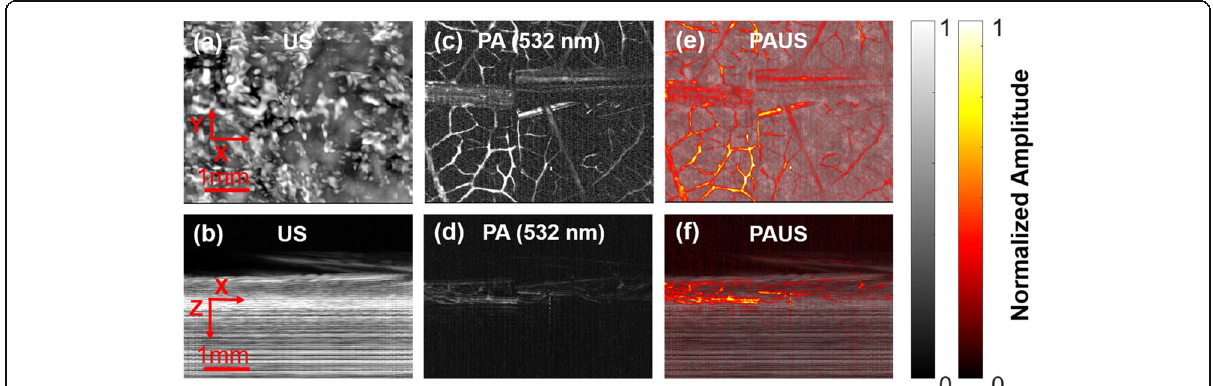
Fig. 2 Concurrent PAUS results of a leaf phantom. The field of view (FOV) in the XY plane is 5 × 4 mm 2 . Inside the FOV, the left part is a red leaf and the right part is a green leaf. Both top view (the XY projection) and side view (the XZ projection) are provided for US ( a , b ), PA ( c , d ), and fused PAUS images ( e , f )